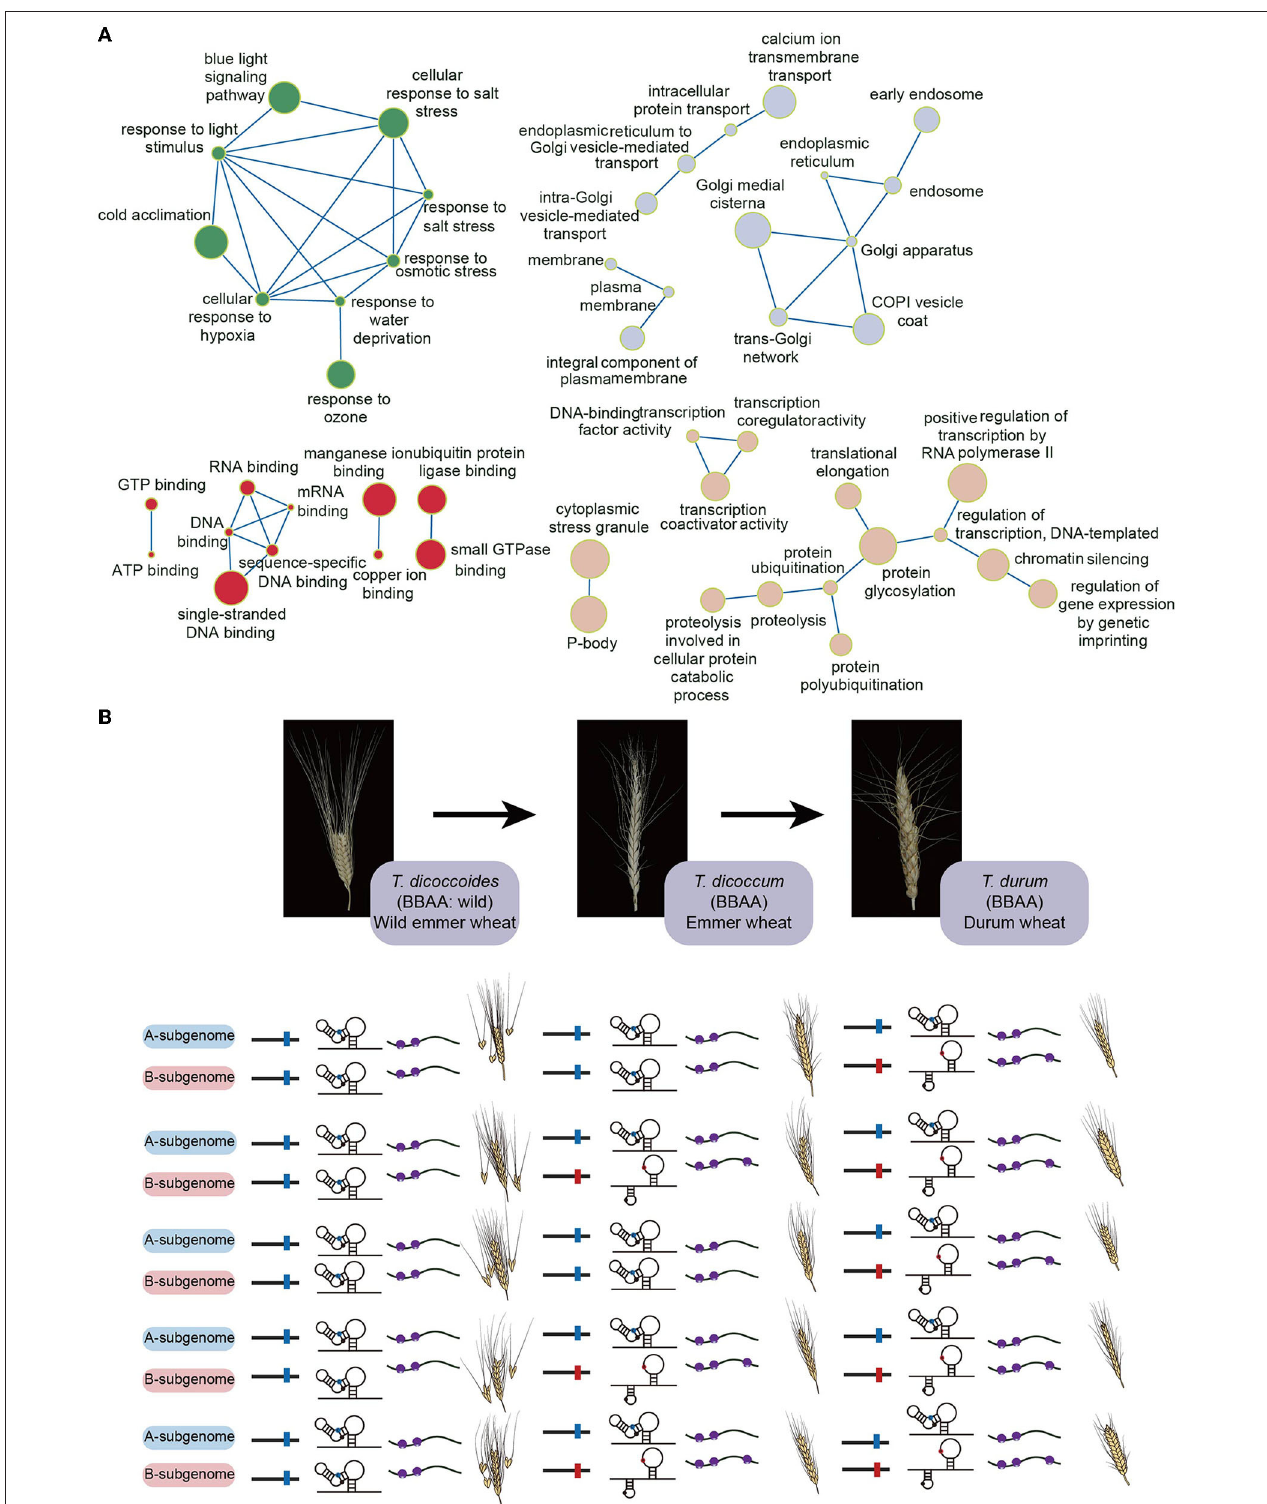
FIGURE 1 | The gene functions of wheat homoeologous pairs preferring RNA structure-mediated translational subgenome asymmetry and the evolved riboSNitch during wheat domestication. (A) The detailed gene functions of wheat homoeologous pairs have significant correlation coefficients between subgenomic RNA structural and subgenomic translational differences (Yang et al., 2021). The green circles highlight the functions related to the responses to stimulus; the gray circles